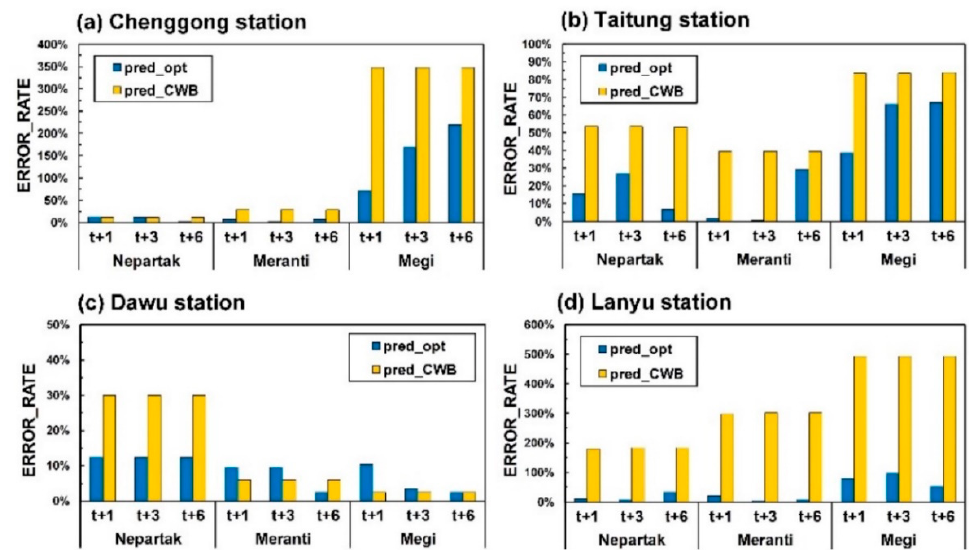
Figure 14. Comparison of ERROR_RATE of pred_opt and pred_CWB: ( a ) Chenggong; ( b ) Taitung; ( c ) Dawu; ( d ) Lanyu.